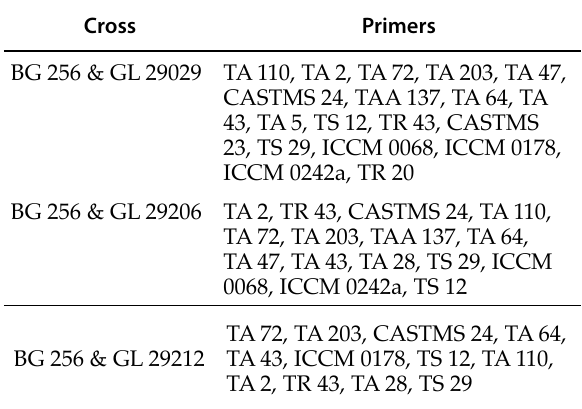
Table 6. Primers showing polymorphism between chick - pea parents involved in crosses. Cross